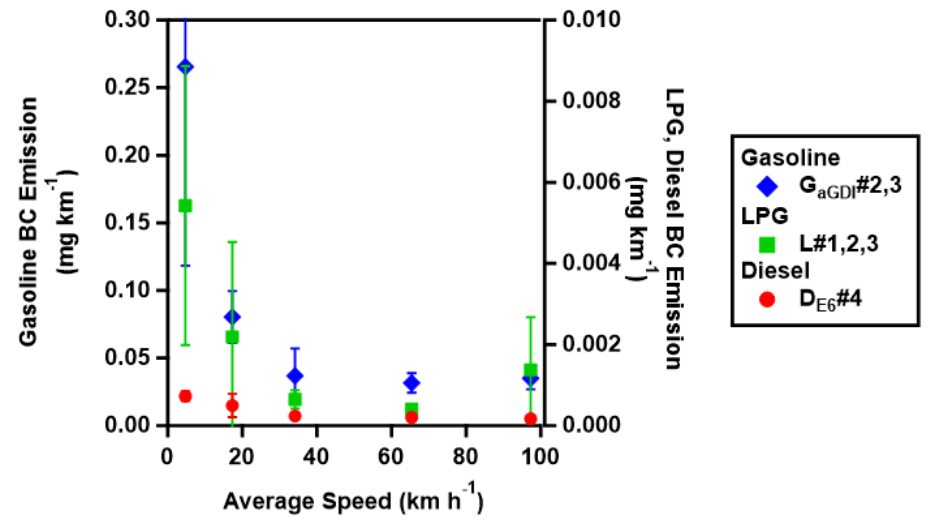
Figure 4. BC emission at five different speeds compared by fuel types (gasoline, LPG, and diesel). Gasoline with GDI engine used vehicle after PM regulation (0.004 g km − 1 ), LPG vehicles, and diesel vehicle in EURO 6.